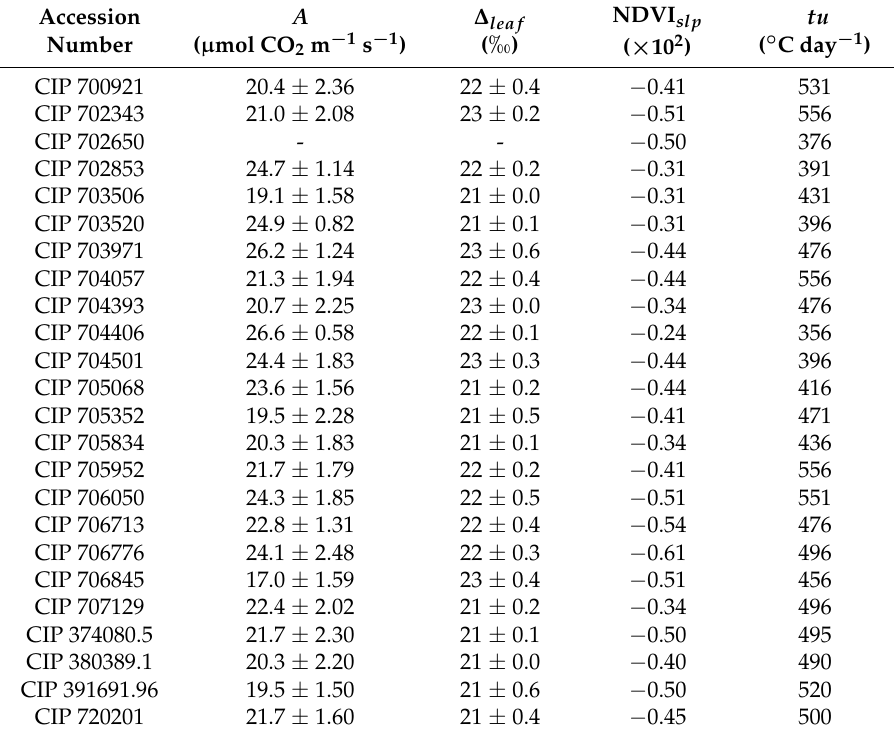
Table 2. Adjusted values of physiological ( A , ∆ leaf ), senescence delay (NDVI slp ) and tuberization precocity ( tu ) parameters for each accession.